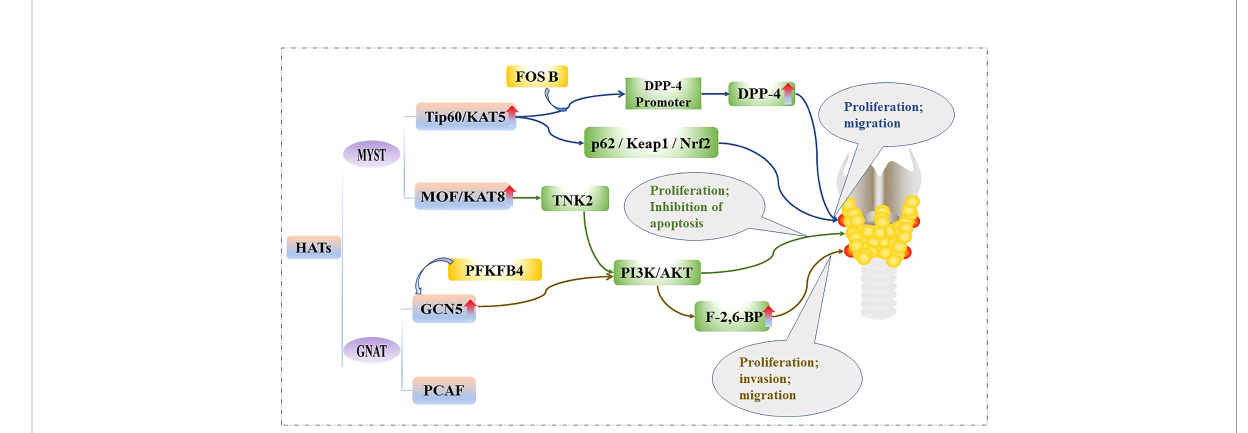
FIGURE 2 Mechanistic pathways of histone acetylation in papillary thyroid cancer. HATs, Histone acetyltransferases; Tip60, 60kDa Tat-interactive protein; KAT5, Lysine acetyltransferase5; FOSB, FBJ murine osteoscarcoma viral oncogene homolog B; DPP-4, Dipeptidyl peptiase IV; p62/Keap1/Nrf2, Sequestosome 1/Kelch-like ECH-associated protein 1/NF-E2-related factor 2; MOF, Males-absent on the fi rst protein; KAT8, Lysine acetyltransferase 8; TNK2, Tyrosine kinase 2; PI3K/AKT, phosphatidylinositol 3-kinase/protein kinase B; GCN5, General control of amino